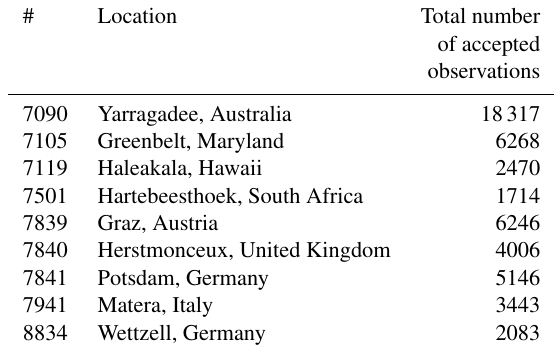
Table 5. SLR stations from which the observations were used with corresponding number of accepted observations for the investigated time period.